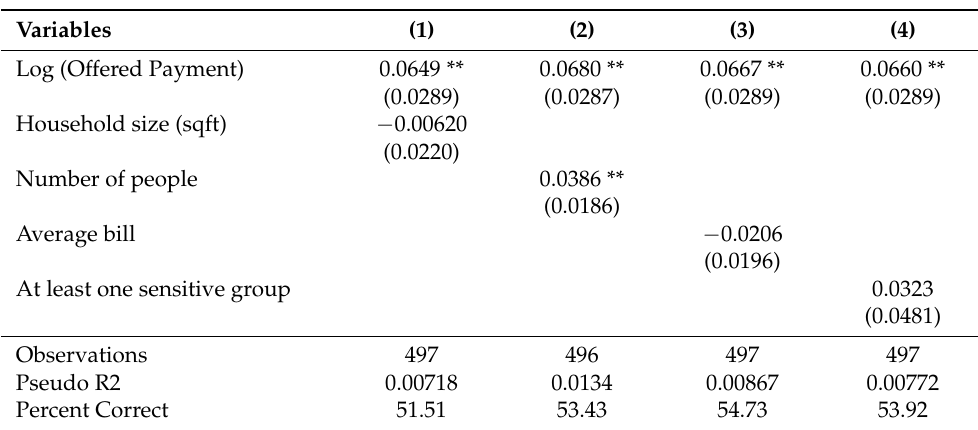
Table 4. Determinants associated with electricity